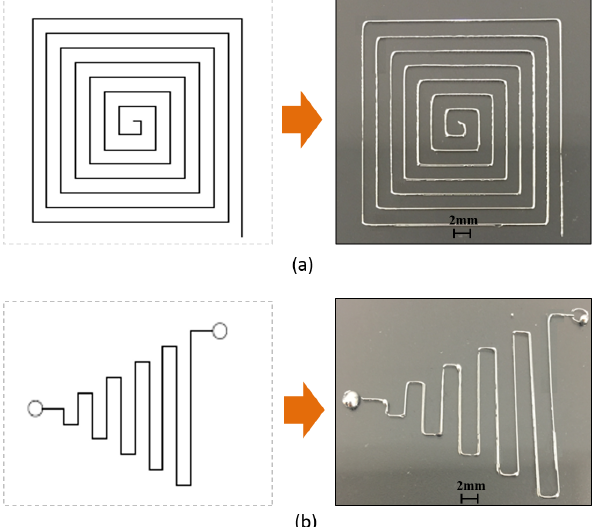
Figure 12. The printed flexible PCB on the PVC film substrate. 0.5 mm writing diameter of the ball head, the printed line widths were basically distributed between 450 and 500